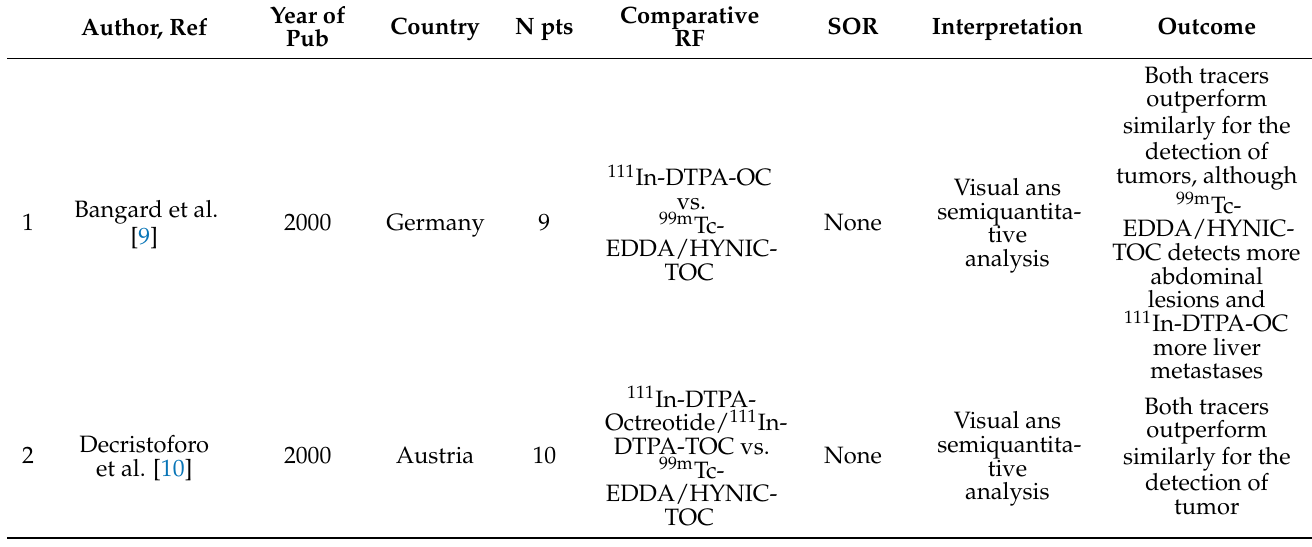
Table 1. Characteristics of the selected studies.